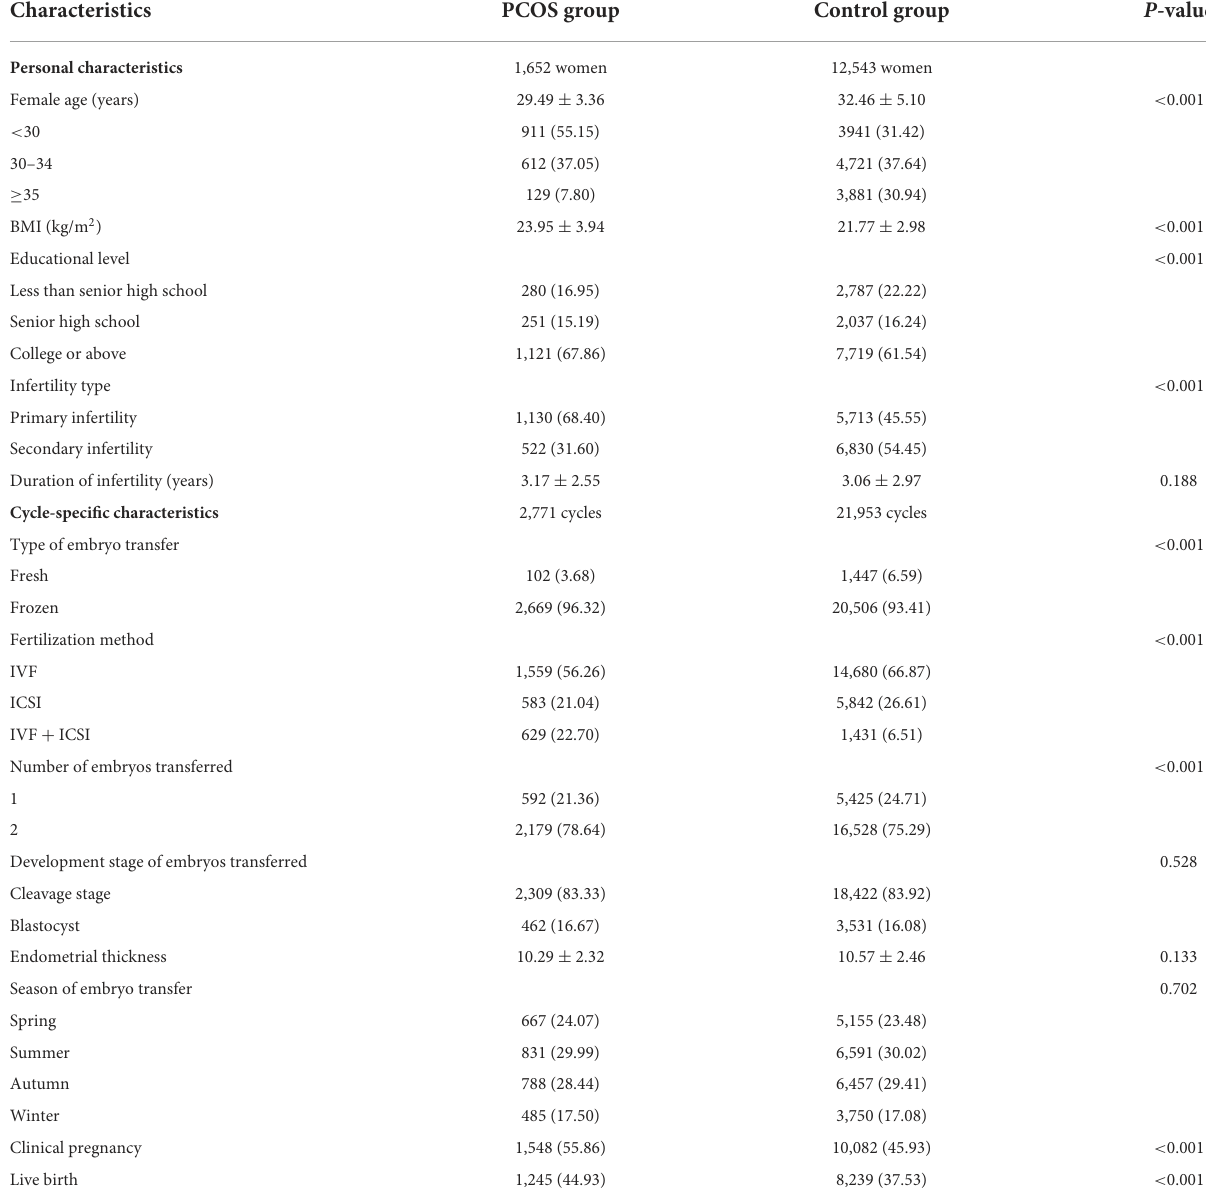
TABLE 1 Demographic and clinical characteristics of 1,652 women with PCOS and 12,543 women without PCOS at baseline of ART